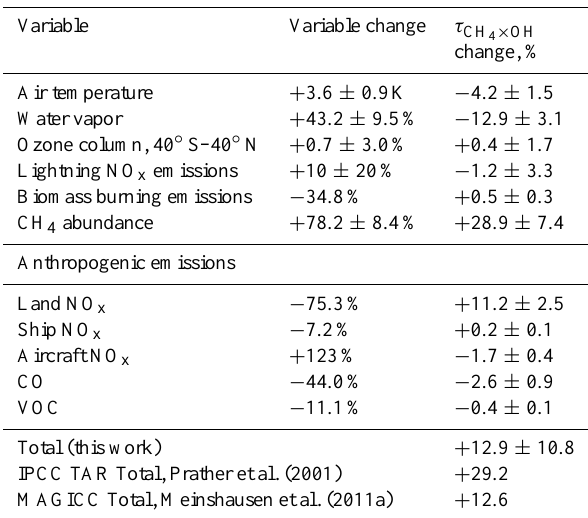
Table 4. Changes (2100 − 2010) in climate, emissions, and τ CH for RCP 8.5 ∗ 4 × OH